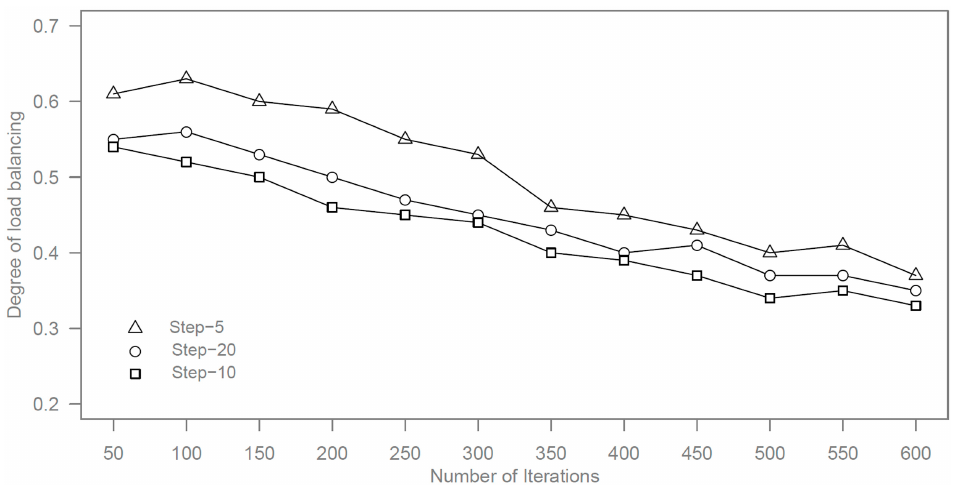
Figure 5. Degree of load balancing by different maximum searching